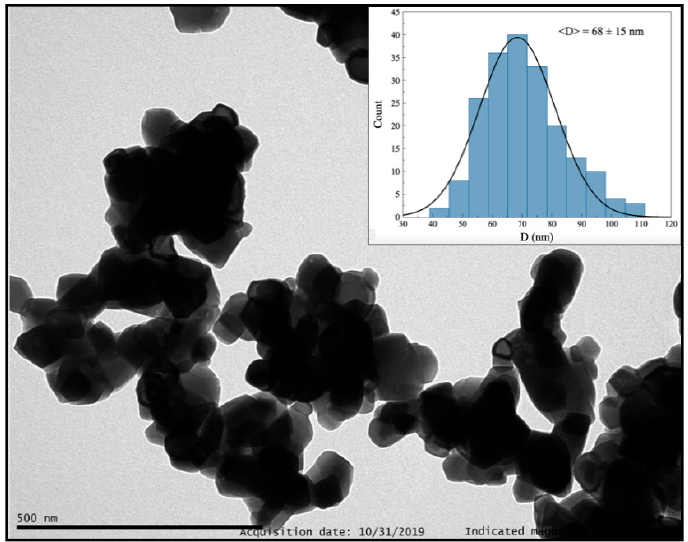
Figure 8. TEM image of Y 2 O 3 : Pr 3+ NCs obtained by solvothermal method at 220 °C followed by calcination at 1000 °C for 4 h.